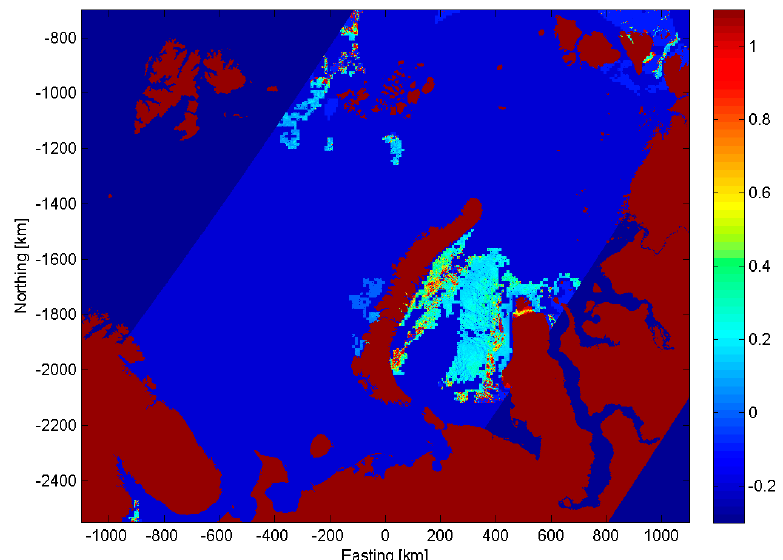
Figure 9. Sea ice thickness chart calculated using the MODIS ice surface temperature chart shown in Figure 8b. MODIS data was acquired on 11 January 2016, 08:55 UTC. Vertical bar shows sea ice thickness scale from 0 to 1 m. Other thickness values represent various masks, see Section 4.1.2.